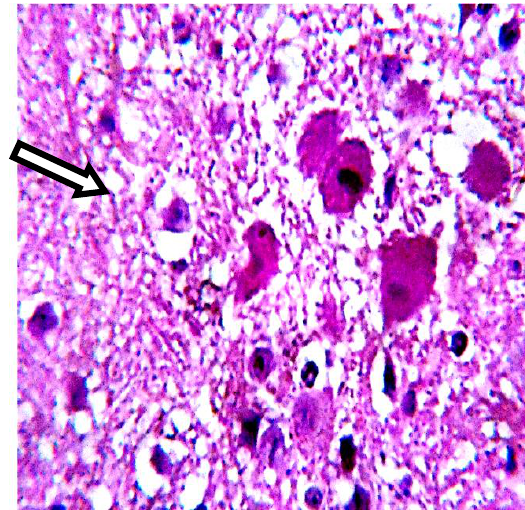
Fig:15 Histopathological section in Brain,T2,show Fig:16 Histopathological section Brain,T2,show type– I I astrocyte characterized by pair of nuclei of extracellular edema characterized by space arrangement surrounded by clear space around neuron (H&E stain.